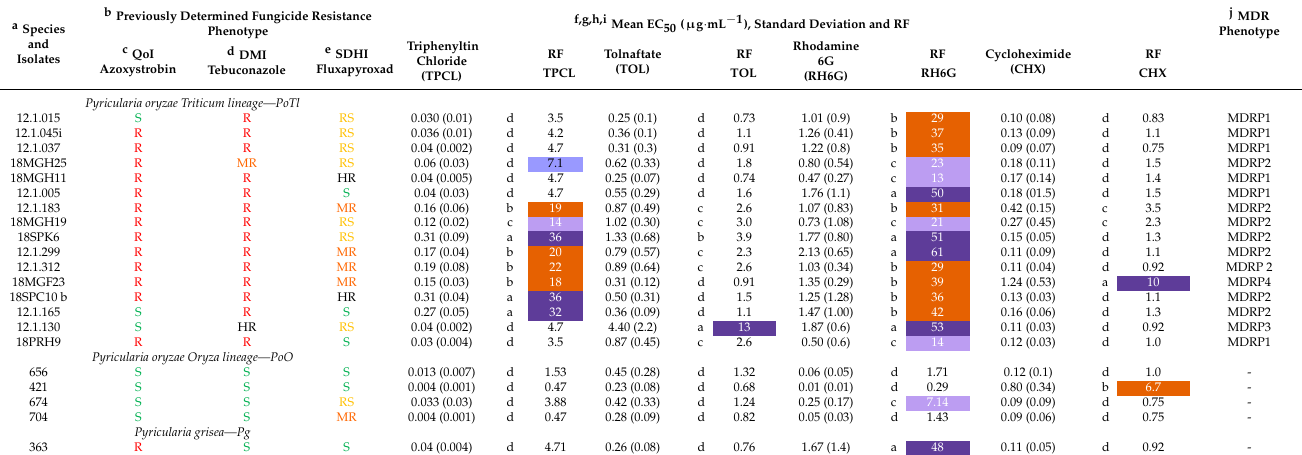
a The PoT l strain coding indicates the respective sampling year: ‘12’ for 2012 populations and ‘18’ for 2018 populations; PoO l and Pg isolates were from 2012 populations. b Sensitivity phenotype classes: S = sensitive, RS = reduced sensitivity, MR = moderately resistant, R = resistant, HR = highly resistant. c According to Cas- troagud í n et al. [6]: R isolates grew at the discriminatory dose of 10 µ g · mL − 1 . d According to Poloni et al. [9]: S, EC MR, EC 50 = 21.83–43.67 µ g · mL − 1 ; HR ≥ 50–100 µ g · mL − 1 . f Effective concentration to inhibit fungal growth in 50% (EC 50 ) using mycelial fragment method evaluation by absorbance at 620 nm in microplates. g Means followed by the same letters in the column did not differ by the Scott-Knott test (at p ≤ 0.05). Standard deviation in parenthesis. h Resistance factor (RF) indicates the ratio of the strain’s EC 50 tested to the mean average EC 50 value for strains PoOl 421 and 656 for each antifungal- isolate combination, with exception for cycloheximide where only the EC 50 value of PoOl 656 was used due to insensitivity of strain PoOl 421. i RF within each substrate: dark purple = very high, orange = high, light purple = medium. j Multidrug-resistance phenotype of PoT l strains (MDRP) classification according to the combination of resistance to different efflux pump substrates and resistance to tebuconazole (DMI) and/or fluxapyroxad (SDHI). All 16 PoT l strains and 1 PoO l strain (674) showed raised EC 50 values to rhodamine 6G (RH6G) (Table 2). The RFs ranged from 13- to 61-fold for the PoT l strains with the highest EC 50 value, 2.13 µ g · mL − 1 , measured for strain 12.1.299 (Figure 1B). A lower RF value of 7.1 was measured for the RH6G sensitive PoO l strain 674.